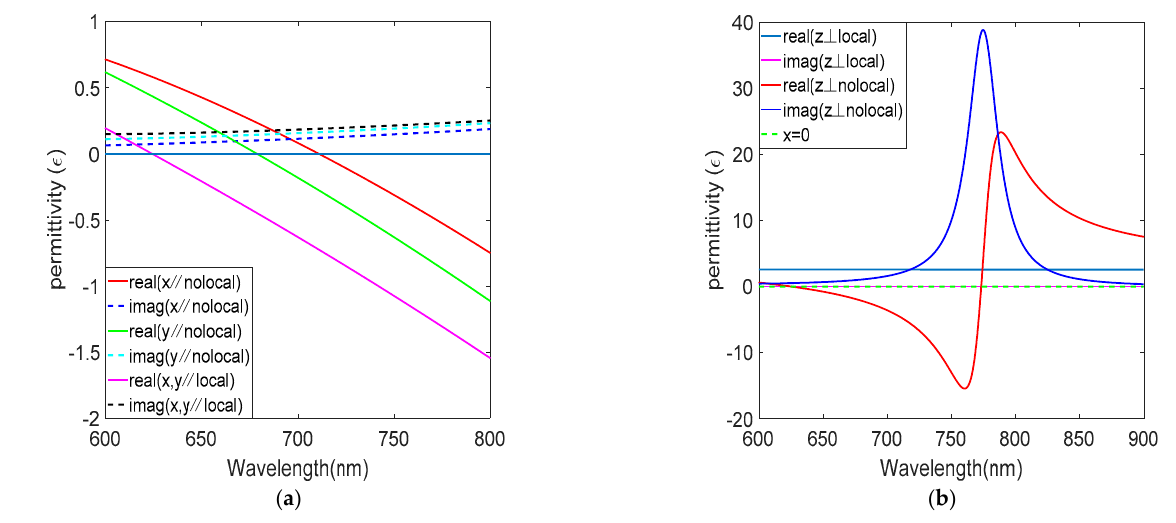
Figure 3. Permittivity without gain medium. ( a ) Permittivity of in − plane local and nonlocal. ( b ) Permittivity of out − of − plane local and nonlocal.